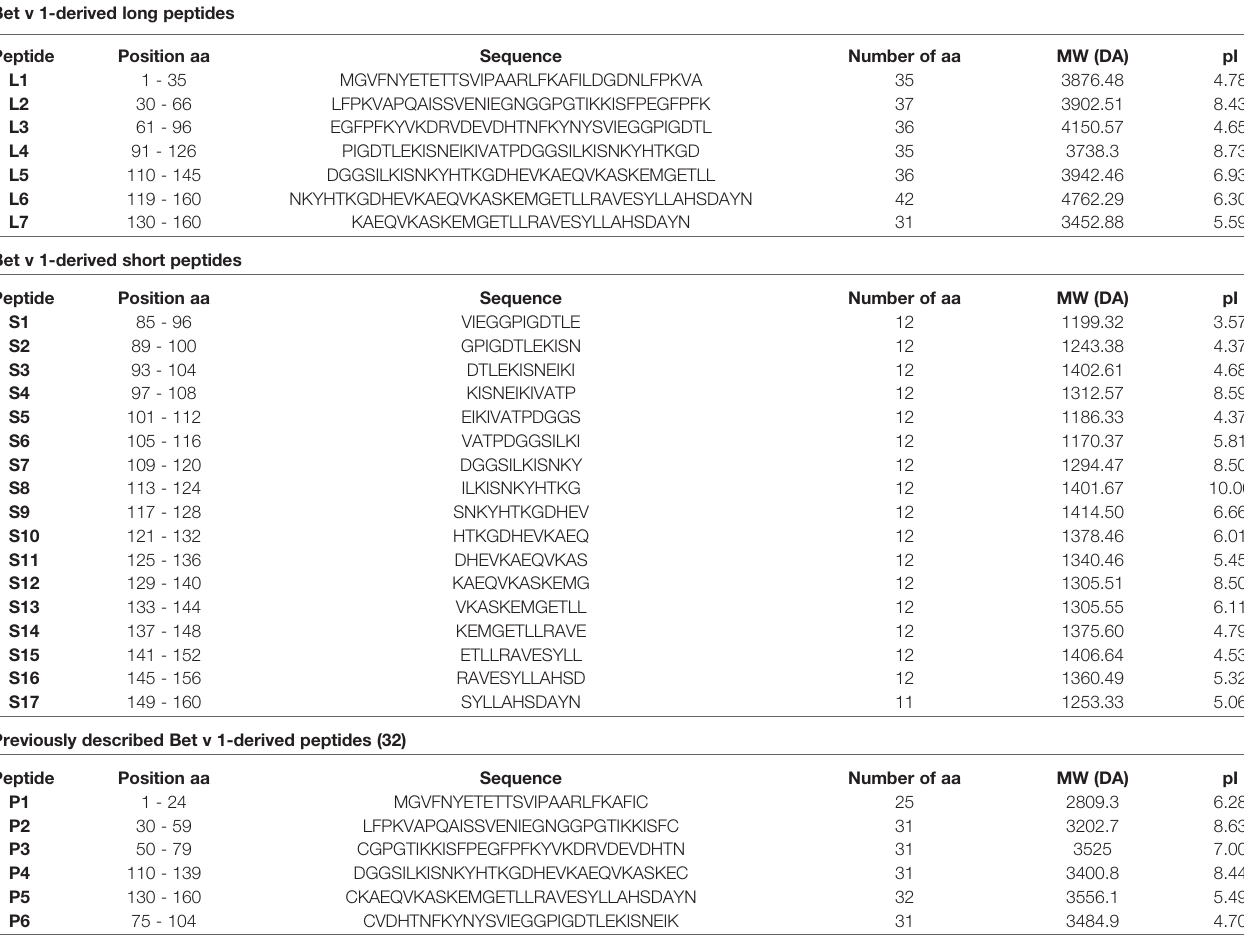
TABLE 1 | Characteristics of Bet v 1-derived synthetic peptides. Bet v 1-derived long peptides Peptide